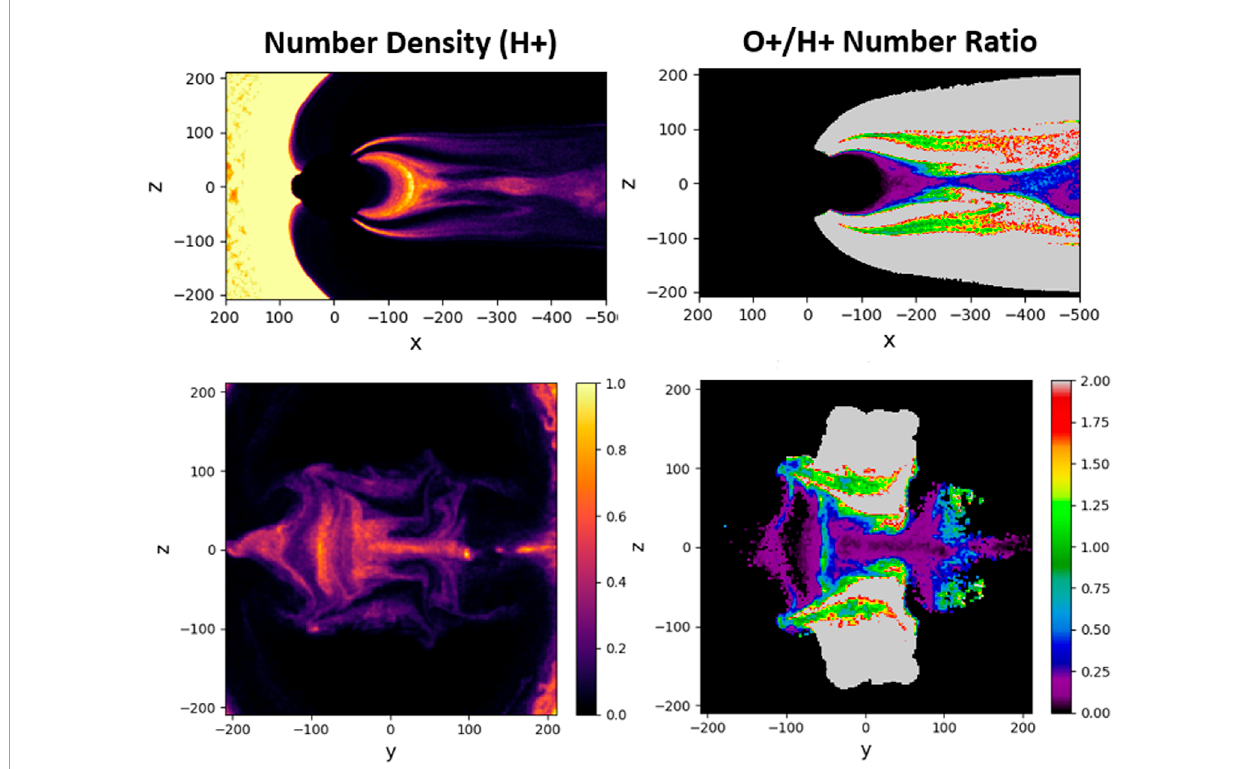
FIGURE 5 H+ number density and O+/H+ number ratio in two cross-sections in the second lobe outflow simulation at Ω cp t = 314: x–z ( y = 1 d i ) and y–z ( x = − 199 d i )